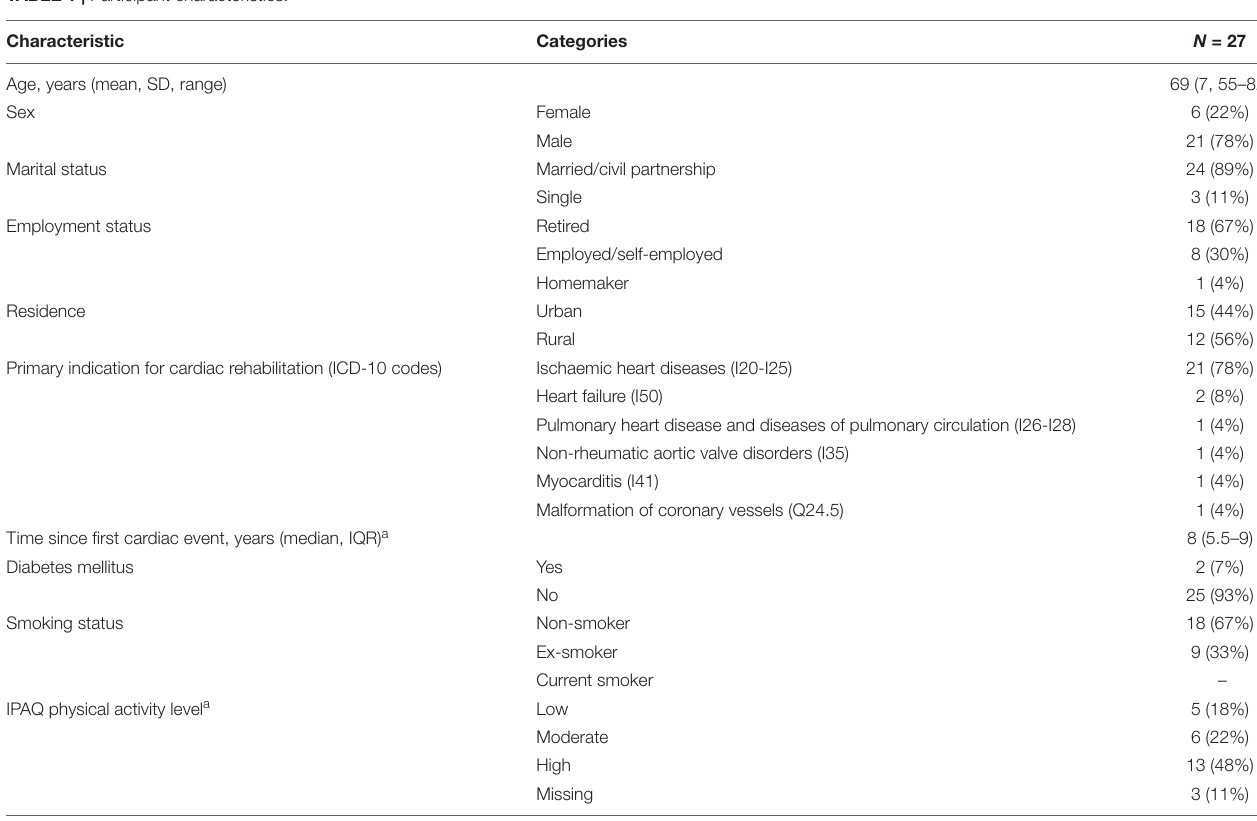
TABLE 1 | Participant